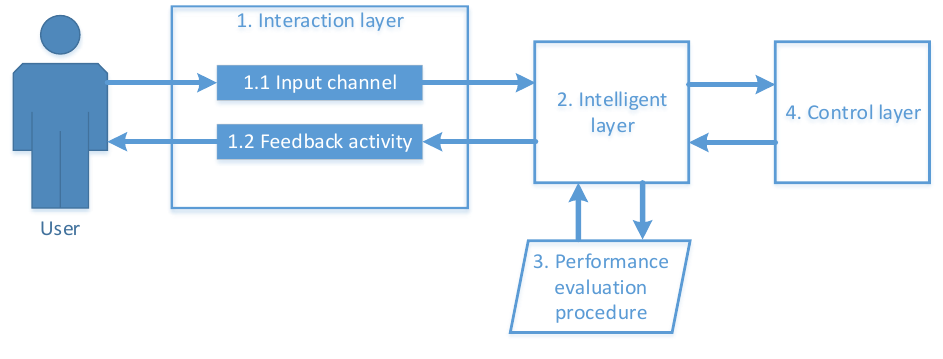
Figure 2. Human-assistive HCI